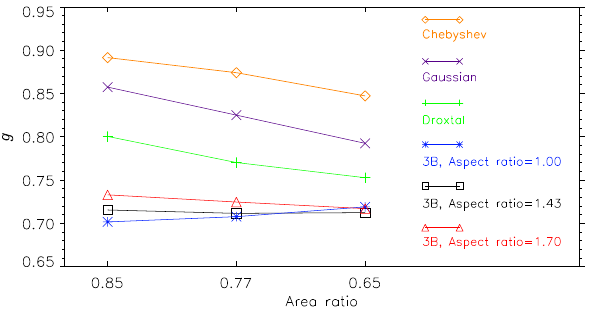
Fig. 14. The g of idealized models representing small ice crystals. In addition to g of 3B with aspect ratio of 1.43, the g for 3Bs with aspect ratio of 1.0 and 1.7 are also embedded.